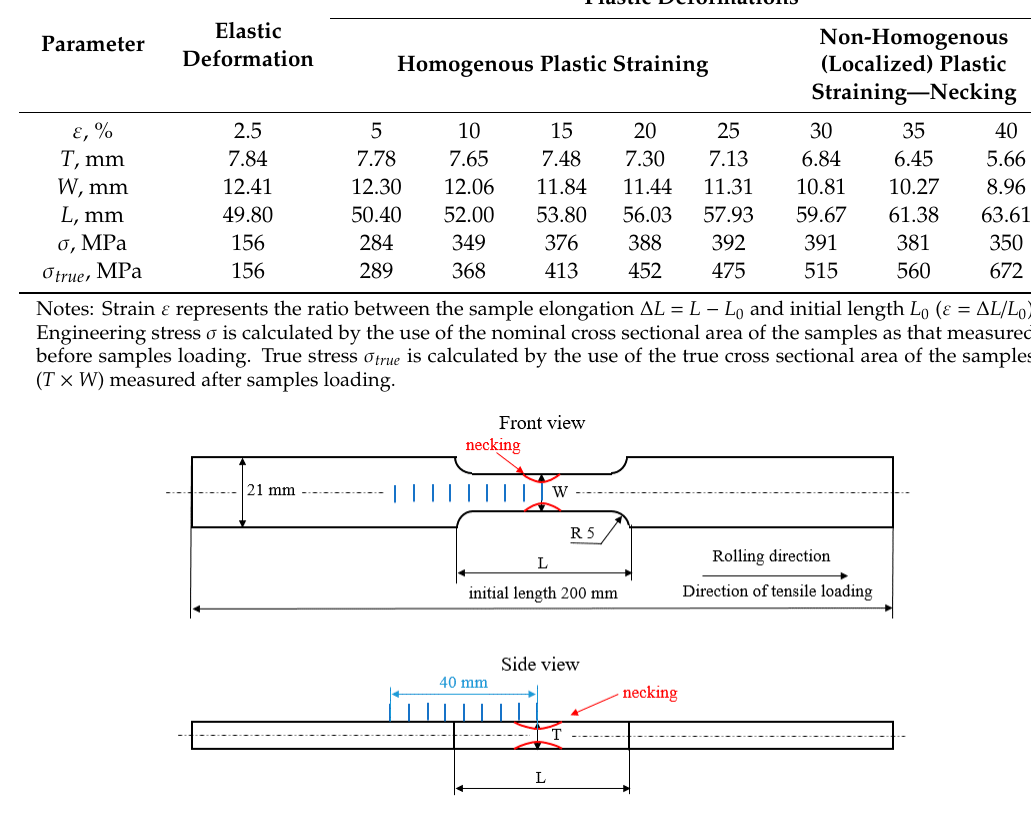
Figure 1. Brief sketch of the samples and positions of the analyzed points, initial L = 49.80 mm, T = 7.84 mm, W = 12.41 mm, distance between the neighboring blue lines 5 mm. Materials 2020 , 13 , x FOR PEER REVIEW 4 of 18